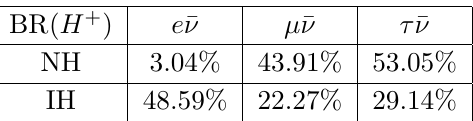
Table 3 . Benchmark decay branching ratios of singly charged Higgs for NH and IH spectra. They are obtained by fixing the neutrino mass and mixing parameters at their best-fit values, and the lightest neutrino mass is assumed to be m = 10 − 4 eV for NH (IH). We assume vanishing Majorana 1(3) phases. The light neutrinos in final states are summed